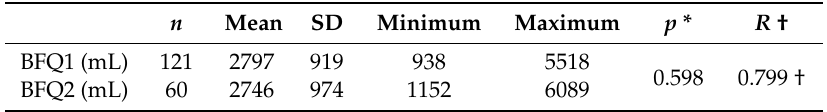
Table 3. Reliability of the beverage frequency questionnaire